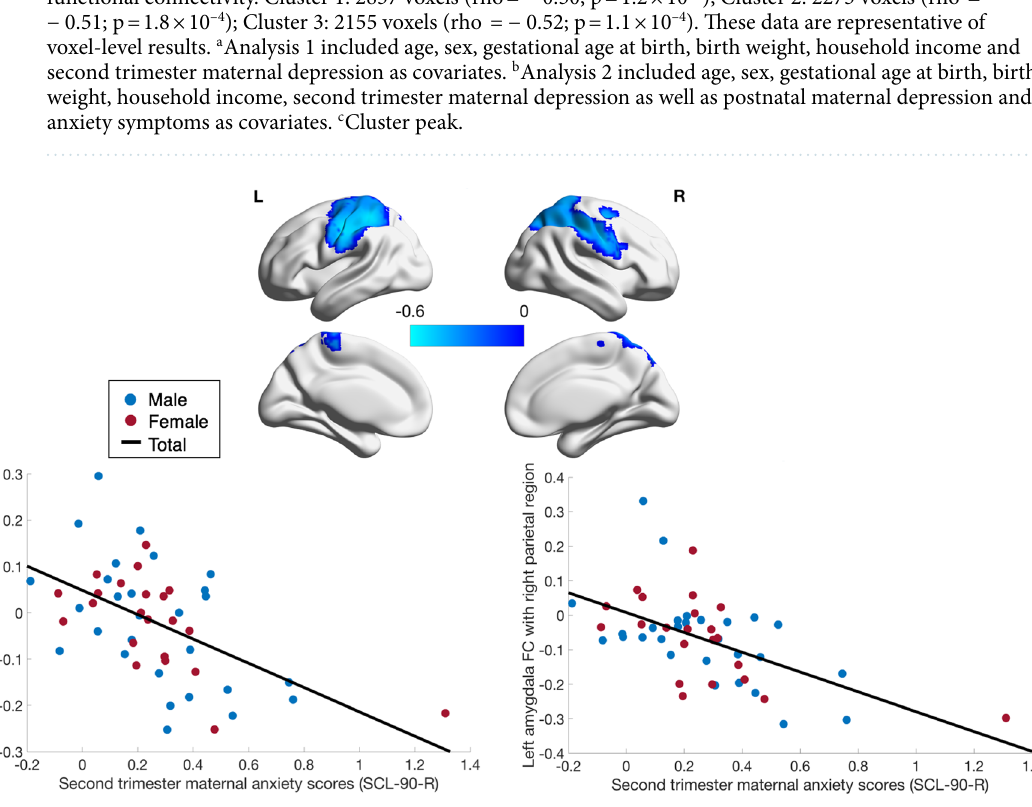
Figure 3. Relationship between maternal prenatal anxiety and amygdala functional connectivity controlling for postpartum depression and anxiety. A correlation analysis between second trimester SCL-90-R scores and left amygdala functional connectivity controlling for postnatal anxiety (SCL-90-R) and depression (EPDS), in addition to child’s age, sex, birth weight, gestational age at birth, household income and prenatal depressive symptoms was performed. Second trimester SCL-90-R scores were negatively correlated with functional connectivity between the left amygdala and two clusters in the left and right parietal regions both shown in blue. The data plotted are residuals of anxiety scores and cluster-averaged left amygdala functional connectivity after accounting for covariates. Prenatal anxiety scores and connectivity between the left amygdala and the left parietal region is plotted on the left (Cluster size: 2275 voxels; rho = − 0.51, p = 1.8 × 10 –4 ; Peak: − 46, − 17, 39— left postcentral gyrus) while connectivity between the left amygdala and right parietal region is plotted on the right (Cluster size: 2155 voxels; rho = − 0.52, p = 1.1 × 10 –4 ; Peak: 50, − 11, 30—right postcentral gyrus). Results were corrected for multiple comparisons at voxelwise and cluster p < 0.05 ( n =